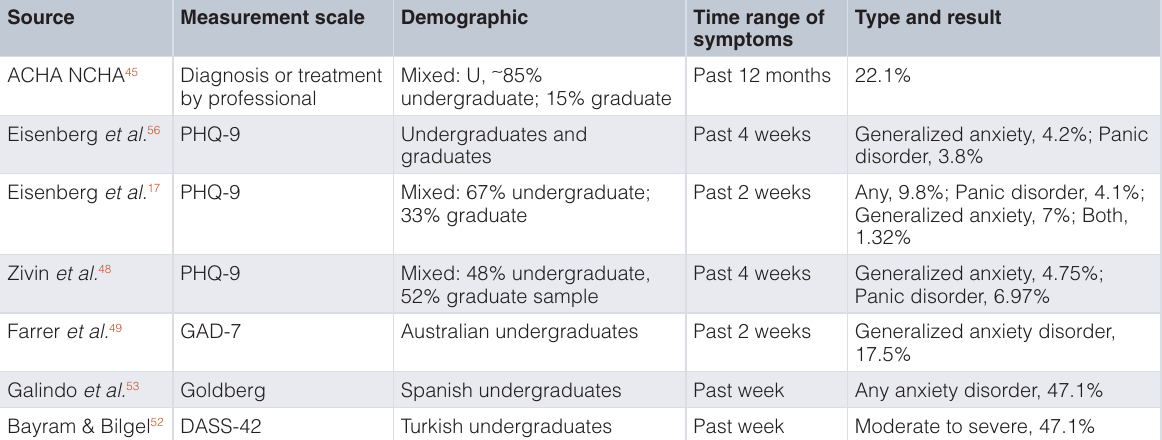
Table 4. Representative anxiety rates among undergraduate and other students. Please refer to Table 1 for